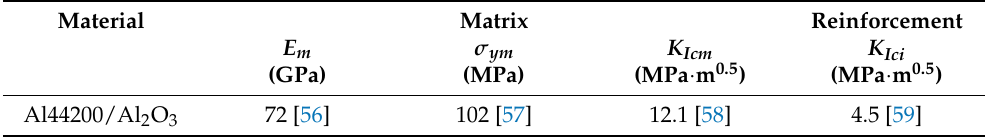
Table 2. Mechanical parameters of the matrix and reinforcement materials used in the Al44200/Al 2 O 3 composite.